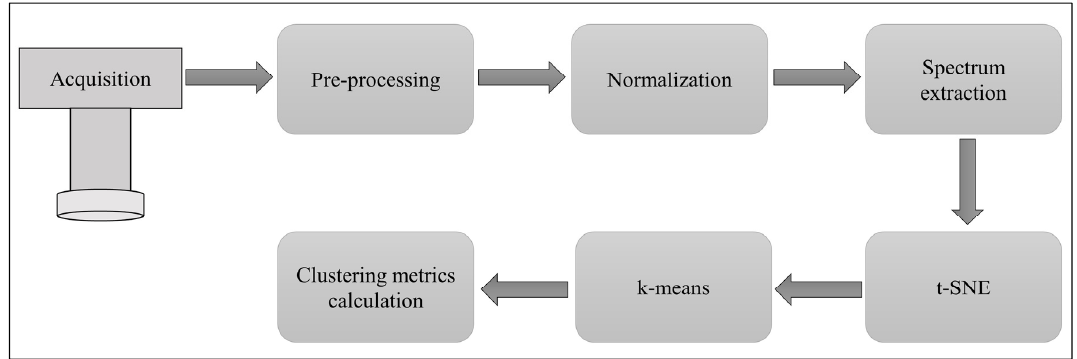
Figure 4. Data processing pipeline for the proposed method .